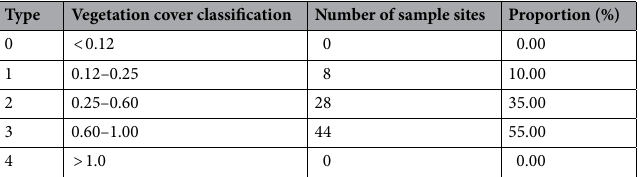
Table 1. Analysis of marmot sample sites under different vegetation cover